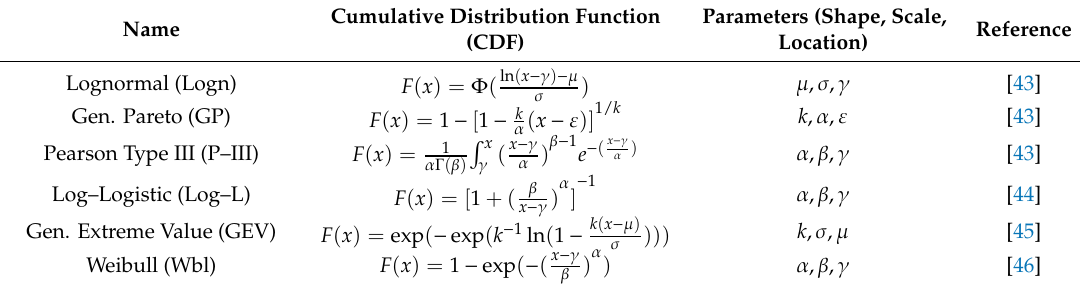
Table 1. Six three-parameter distribution functions used in this